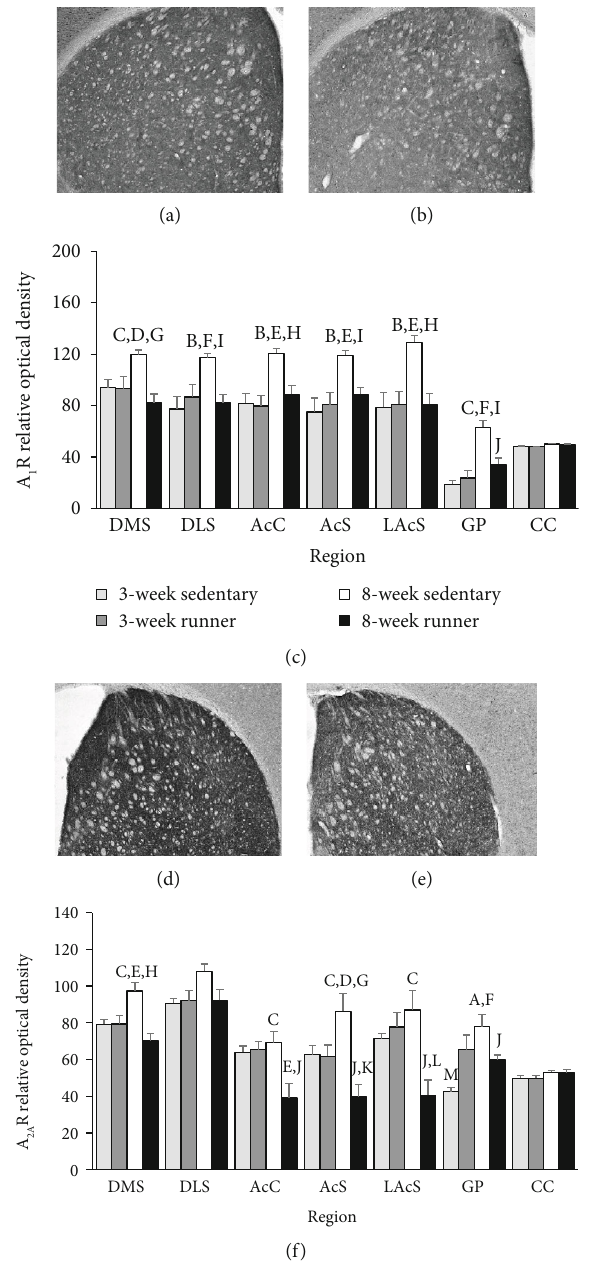
Figure 1: Striatal A R and A R protein expression following three or eight weeks of wheel running. Representative immunohistochemistry 1 2A images for A R in the mouse striatum following eight weeks of (a) sedentary conditions and (b) running wheel access. (c) Relative levels of 1 R protein density represented as averages across sections as detailed in the Methods. Representative immunohistochemistry images for A 1 A R in the mouse striatum following eight weeks of (d) sedentary conditions and (e) running wheel access. (f) Relative levels of A 2A protein density represented as averages across sections as detailed in Methods. Statistical signi fi cance denoted as follows: sedentary 8 weeks vs. runner 8 weeks at A p < 0 : 05 , B p < 0 : 01 , and C p < 0 : 001 . Sedentary 8 weeks vs. runner 3 weeks at D p < 0 : 05 , E p < 0 : 01 , and F p < 0 : 001 . Sedentary 8 weeks vs. sedentary 3 weeks at G p < 0 : 05 , H p < 0 : 01 , and I p < 0 : 001 . Runner 8 weeks vs. sedentary 3 weeks at J p < 0 : 05 . Runner 8 weeks vs. runner 3 weeks at K p < 0 : 05 and L p < 0 : 01 . Sedentary 3 weeks vs. runner 3 weeks at M p < 0 : 05